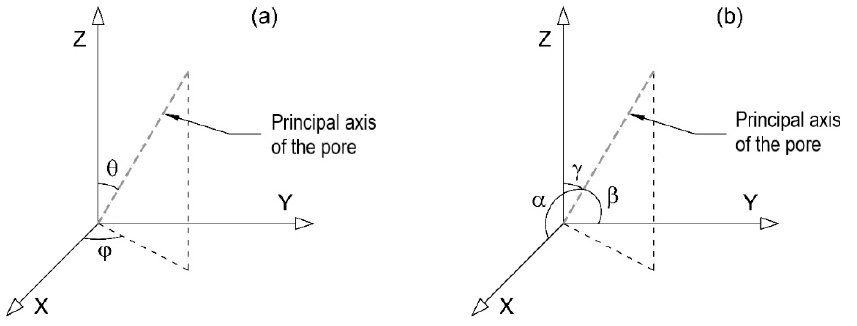
Figure 6. Identification of θ (theta) and φ (phi) angles in Spherical coordinates ( a ), and of α (alpha), β (beta) and γ (gamma) angles in Cartesian coordinates ( b ).